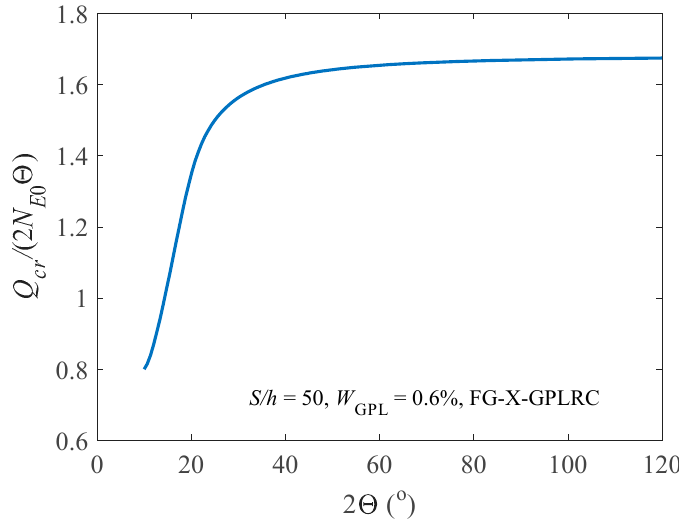
Figure 7. Effect of GPL dimension on buckling loads of the FG-X-GPLRC arch. Figure 7. E ff ect of GPL dimension on buckling loads of the FG-X-GPLRC arch.